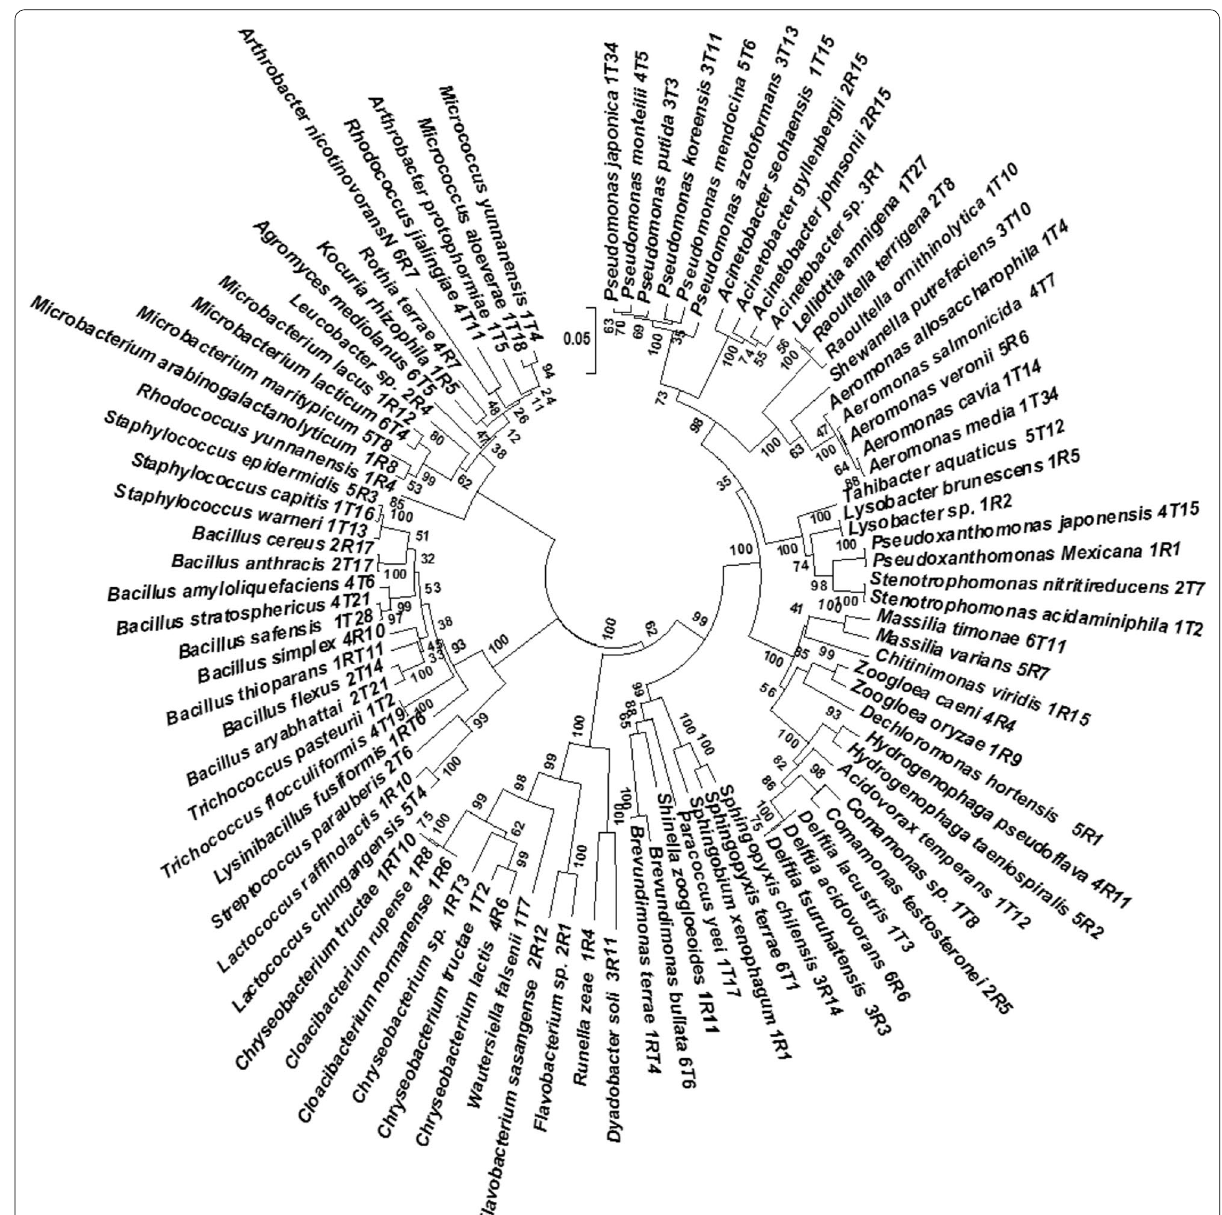
Fig. 1 Neighbor‑joining phylogenetic tree showing the clustering of the 16S rRNA gene sequences of bacterial strains isolated from various STM exposures in biological reactors. The constructed tree was tested by the bootstrap method and bootstrap values are depicted adjacent to each node. The 0.02 scale bar indicates the nucleotide substitution